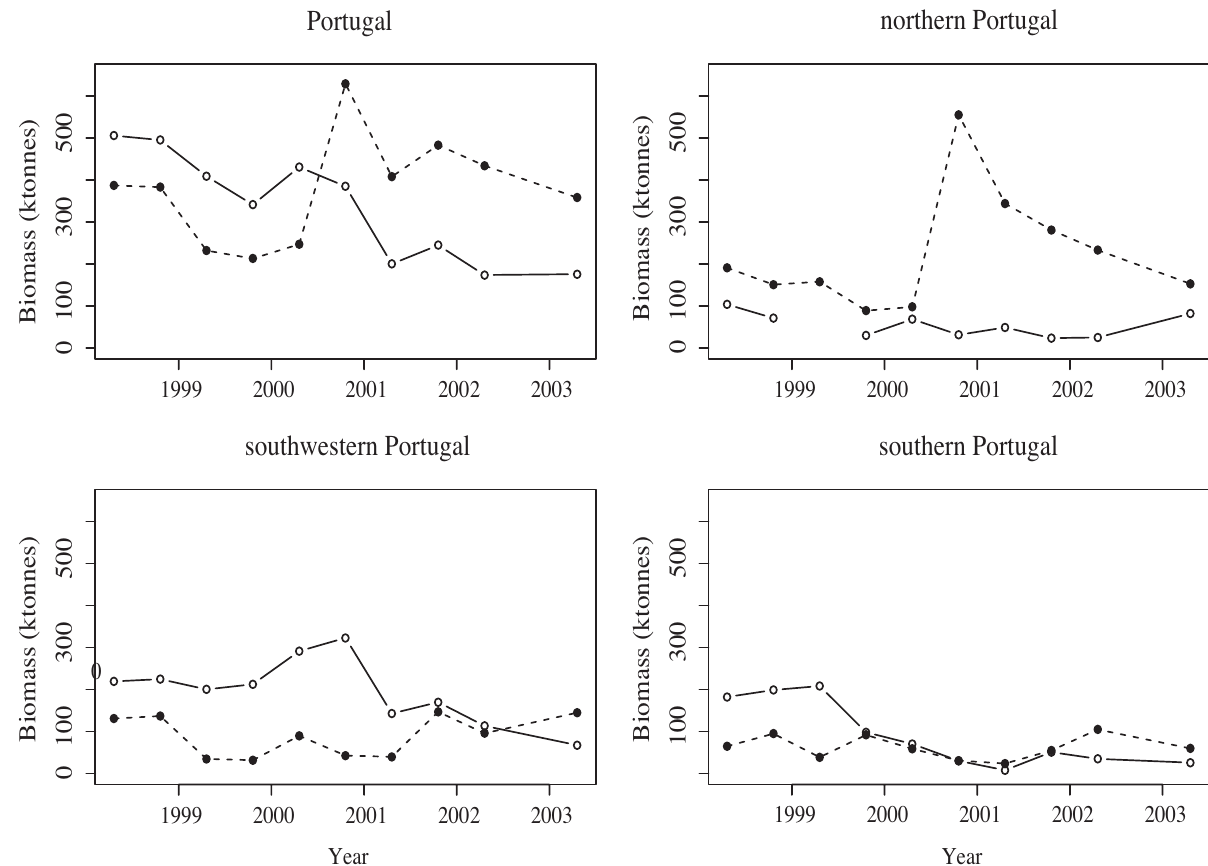
F IG . 7.– Acoustic estimates of snipefish (open circle and solid line) and sardine biomass (closed circle and broken line) within the Portuguese continental shelf during the period 1998-2003, separately according to geographical area and